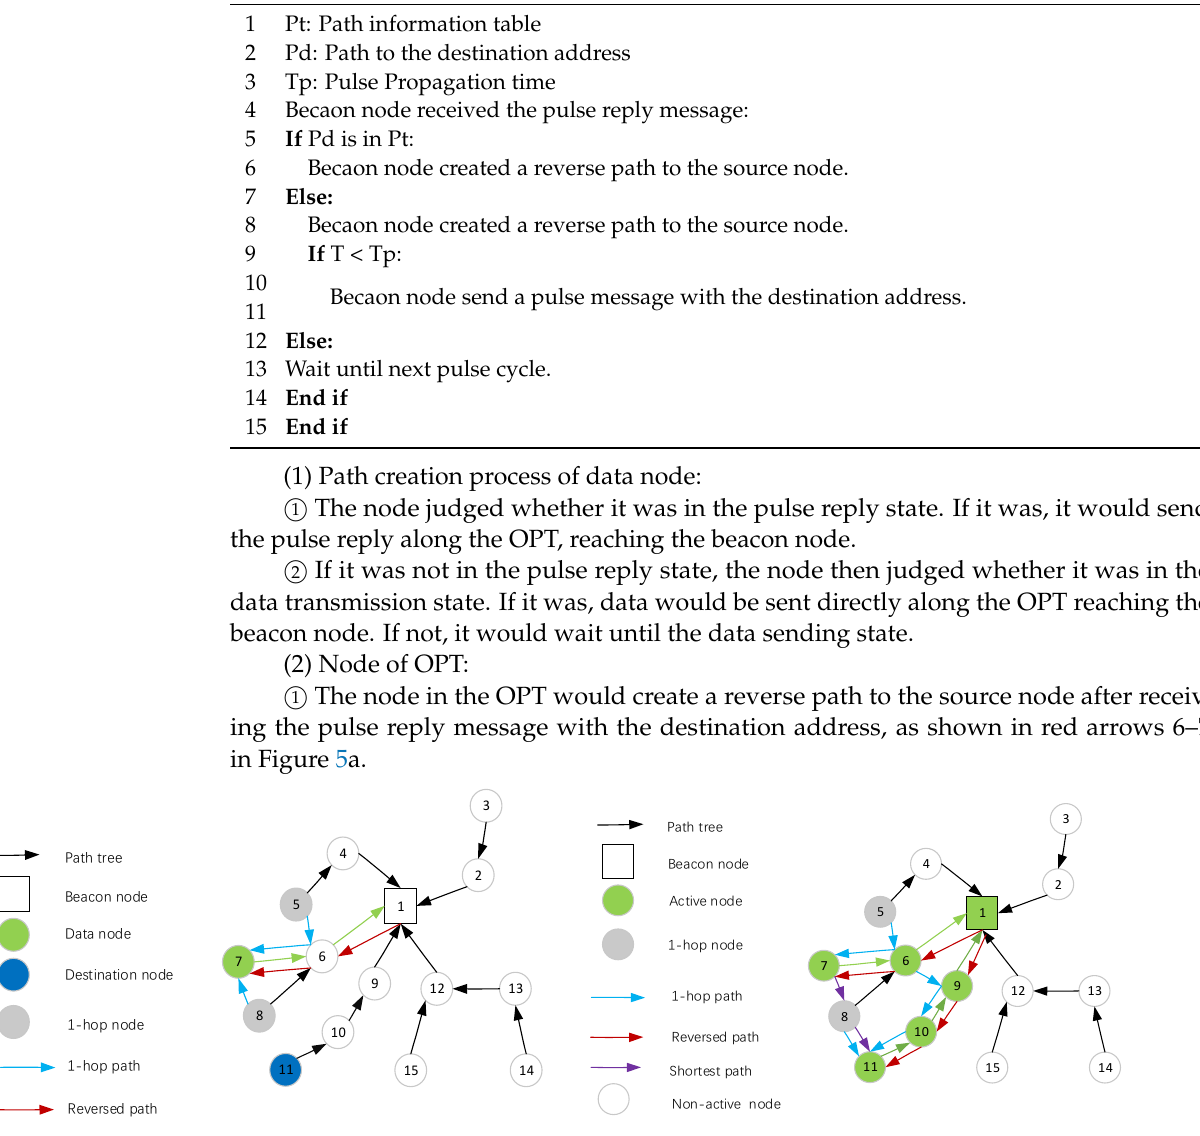
Algorithm 2. Beacon node path request process.